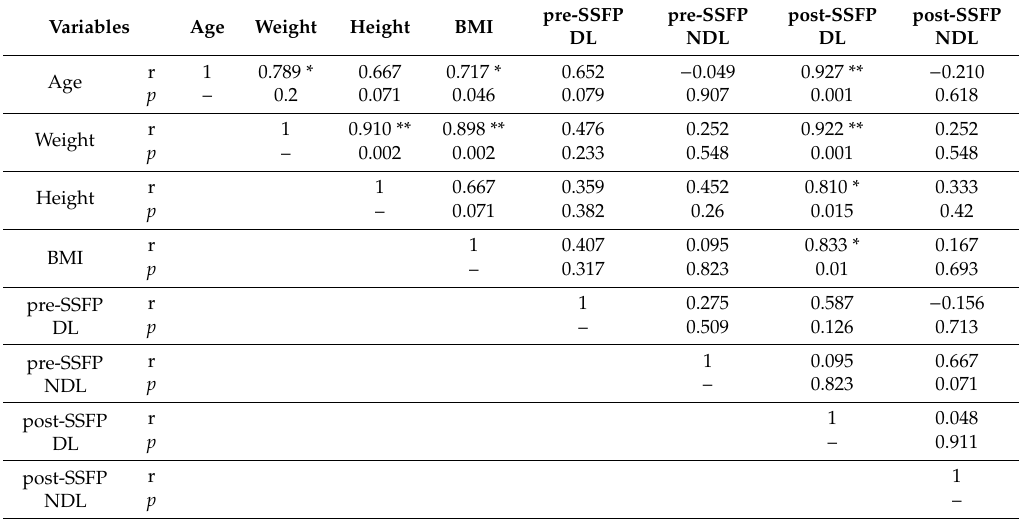
Table 3. Correlations among age / anthropometric variables and SSFP in DL and